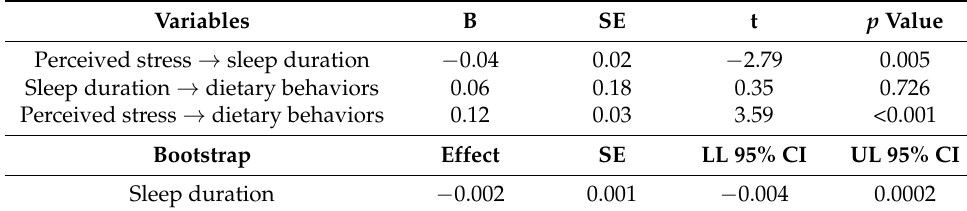
Table 8. Model 2 mediation